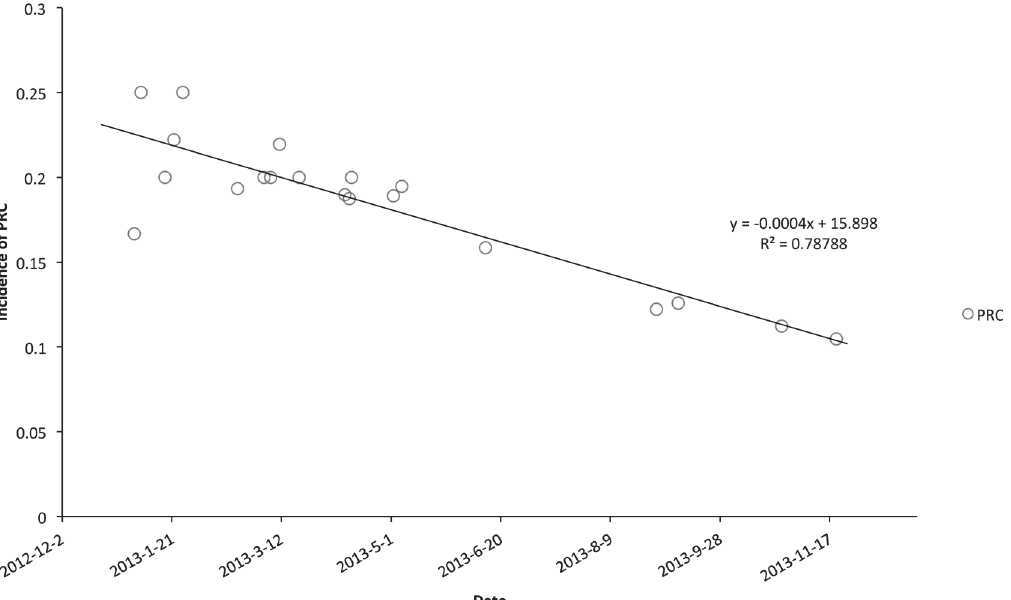
Fig 2. The PRC incidence and date. Simple linear regression analysis is performed to demonstrate the decline tendency of PRC incidence.